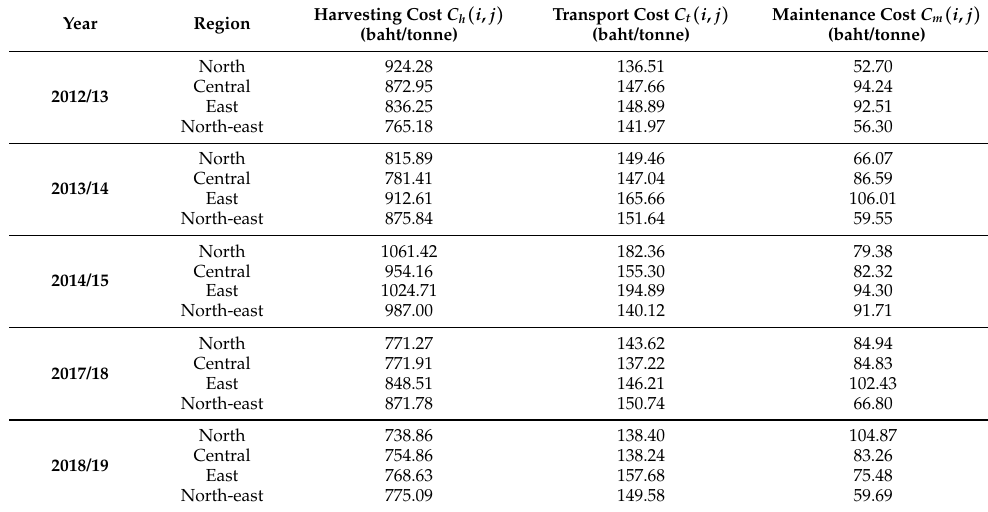
Table 6. The average costs of sugarcane production (baht/tonne) in each region for each crop